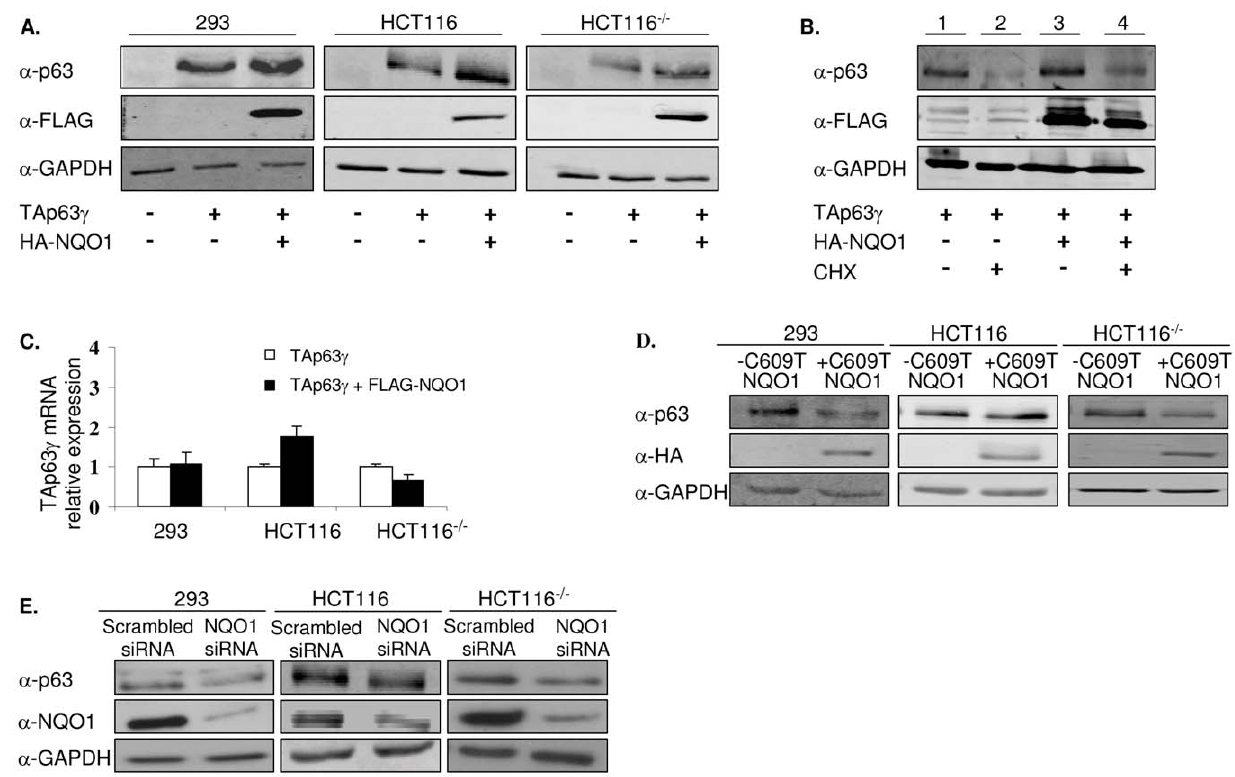
Figure 1. TAp63 c protein is stabilized by NQO1. (A) 293, HCT116 and HCT116 2 / 2 cells expressing endogenous NQO1 or over-expressing wild- type FLAG-NQO1 were transfected with a plasmid expressing TAp63 c . Forty-eight hours post-transfection cell lysates were prepared and resolved by SDS-PAGE. TAp63 c , NQO1 and GAPDH levels were detected by Western blot analysis using anti-p63 (4A4), anti-FLAG and anti-GAPDH (loading control) antibodies, respectively. (B) HCT116 cells expressing endogenous NQO1 or over-expressing wild-type FLAG-NQO1 were transfected with a plasmid expressing TAp63 c . Twenty-four hours post transfection, 10 m g/ml cyclohexamide (CHX) was added for 4 hours. Cell lysates were prepared and resolved by SDS-PAGE. TAp63 c , NQO1 and GAPDH levels were detected by Western blot analysis using anti-p63 (4A4), anti-FLAG and anti-GAPDH (loading control) antibodies, respectively. (C) RNA was prepared from these same cells, reverse transcribed and RT-PCR was performed using primers specific for TAp63 and for gapdh. Data is represented as relative levels of TAp63 c normalized to gapdh. (D) 293, HCT116 and HCT116 2 / 2 cells were co-transfected with plasmids expressing TAp63 c and HA-C609T NQO1. Forty-eight hours post-transfection cell lysates were prepared and resolved by SDS-PAGE. TAp63 c , NQO1 and GAPDH levels were detected by Western blot analysis using anti-p63 (4A4), anti-HA and anti-GAPDH (loading control) antibodies, respectively. (E) 293, HCT116 and HCT116 2 / 2 cells were transfected with scrambled oligonucleotides or siNQO1 oligonucleotides. Twenty- four hours post-transfection cell were transfected with a plasmid expressing TAp63 c . Twenty-four hours post-transfection cell lysates were prepared and resolved by SDS-PAGE. TAp63 c , NQO1 and GAPDH levels were detected by Western blot analysis using anti-p63 (4A4), anti-NQO1 and anti- GAPDH (loading control) antibodies,